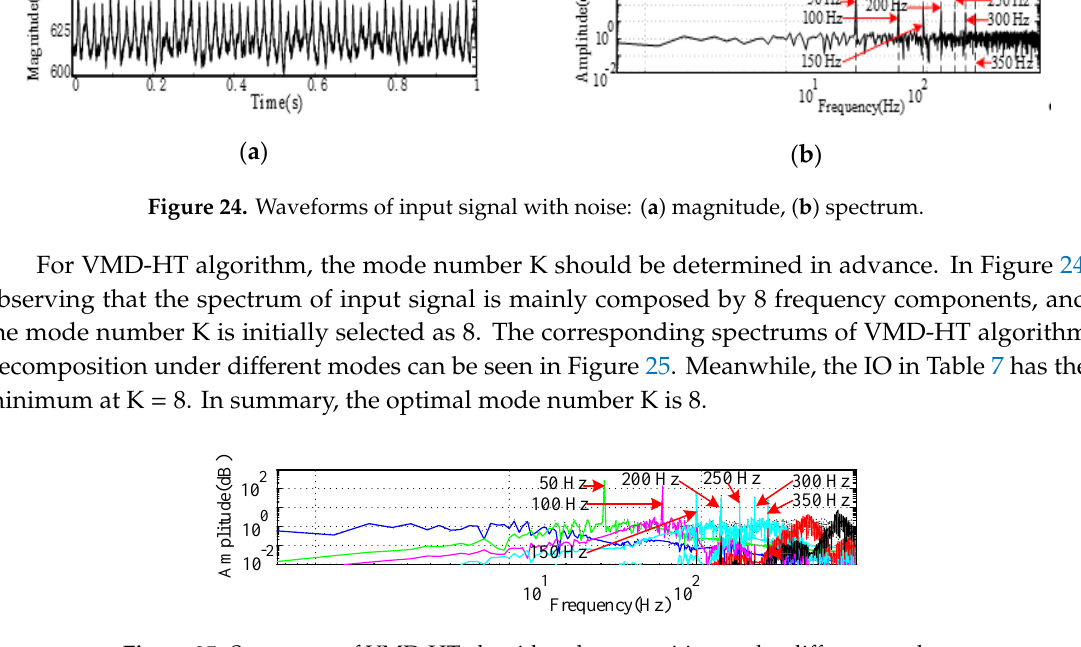
Figure 25. Spectrums of VMD-HT algorithm decomposition under different modes. Table 7. IO of VMD-HT algorithm decomposition under different K.